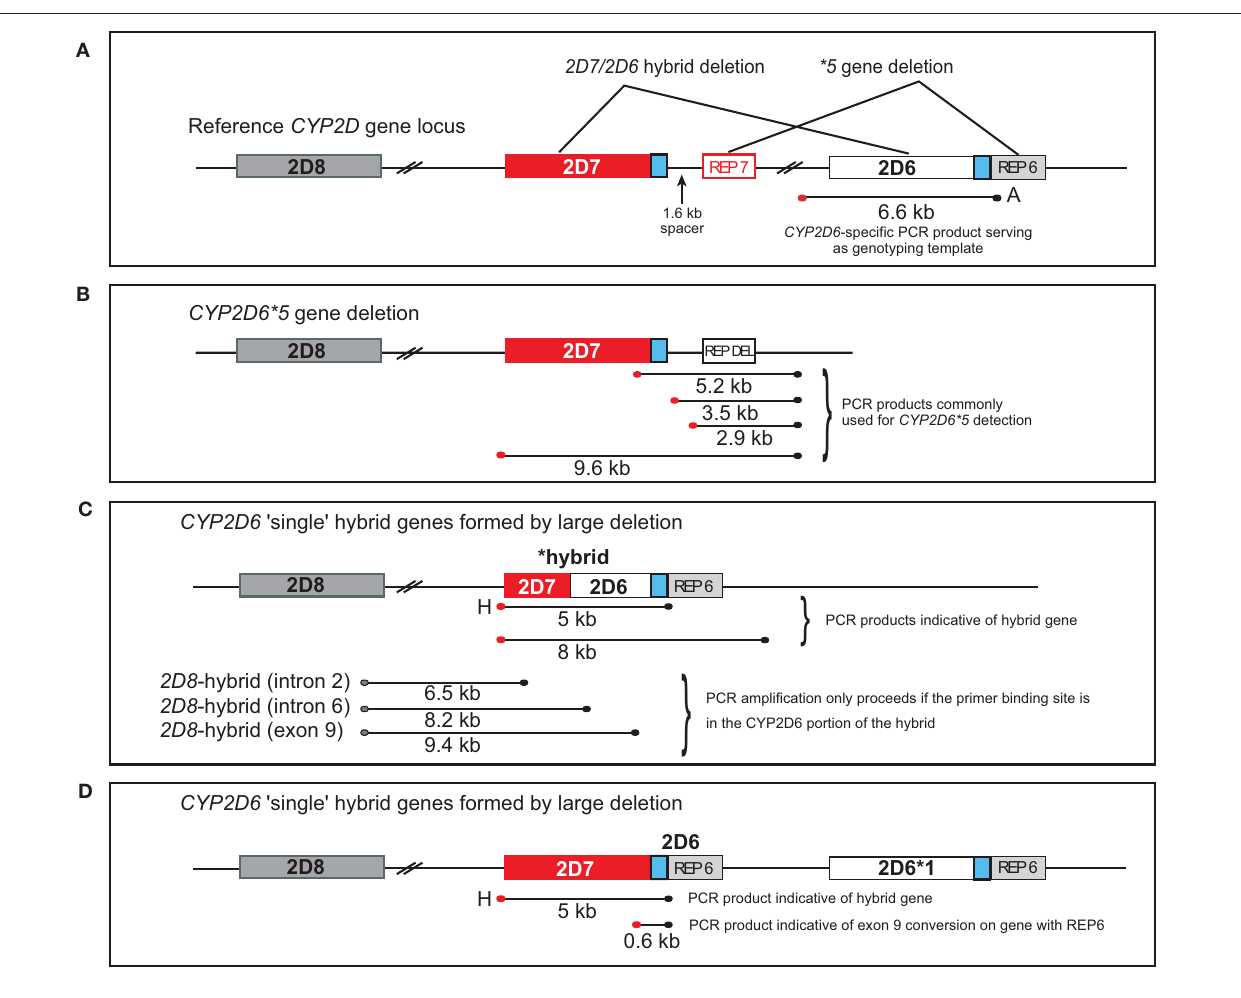
large deletions and implicated in CYP2D7/2D6 hybrid formation and the CYP2D6 * 5 gene deletion are as indicated. (B) Graphic display of the CYP2D6 * 5 gene deletion allele. XL-PCR amplicons utilized for detection are shown. (C) Graphic display of CYP2D7/2D6 hybrid genes and their detection by amplification of fragment H. Other depicted fragments are only amplified, if respective rearrangements are present in a sample. (D) Representation of an allele with a CYP2D7 gene lacking the 1.6-kb spacer. This CYP2D7 variant also supports formation of fragment H although the CYP2D7/2D6 switch occurs in the downstream